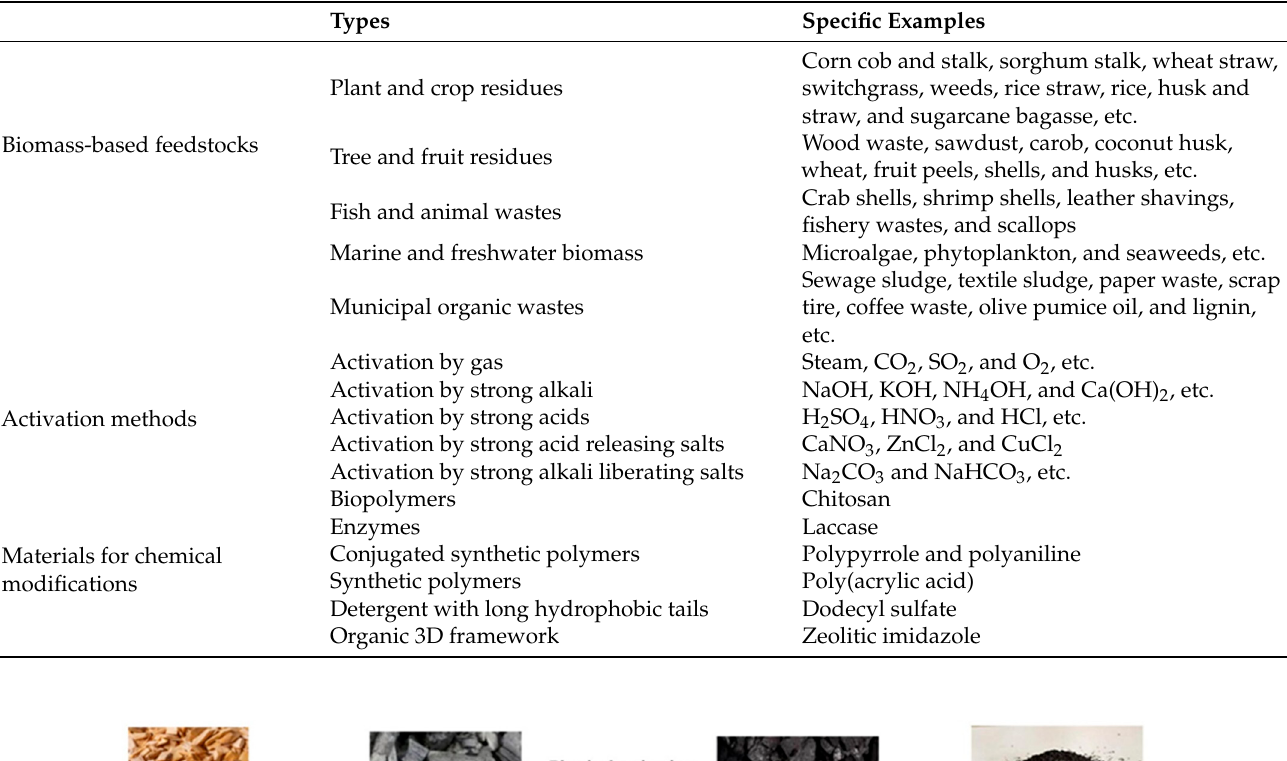
Table 4. Biomass-based feedstocks, activation methods, and chemical modification methods to prepare various types of carbonaceous adsorbents. Prepared based on the information obtained from [80].